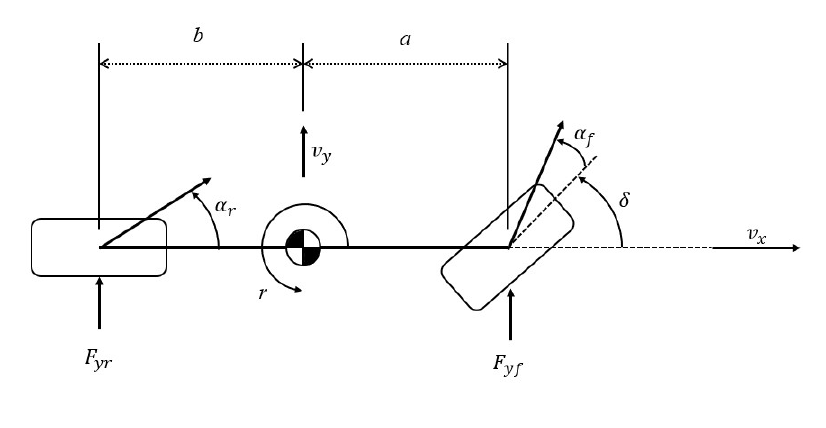
Figure 1. Typical vehicle bicycle model [6,8,13,24,26,27]. The simple four-wheel vehicle model in Figure 2 follows almost identical dynamic equations modelling but with the addition of the two missing wheels. The limitations remain the same, no proper tire-road interaction and very simplified tire